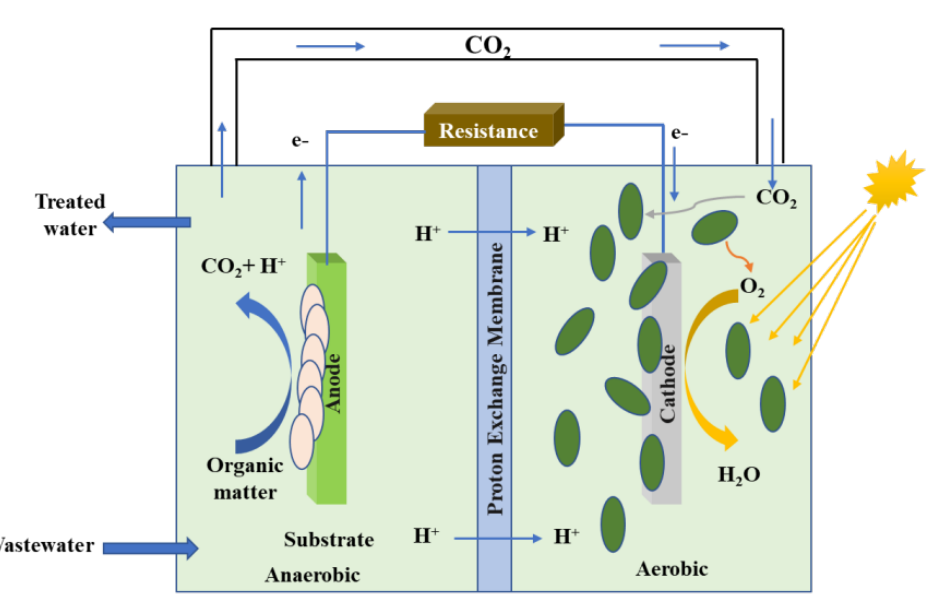
Figure 4. A schematic diagram of a microbial carbon capture cell.